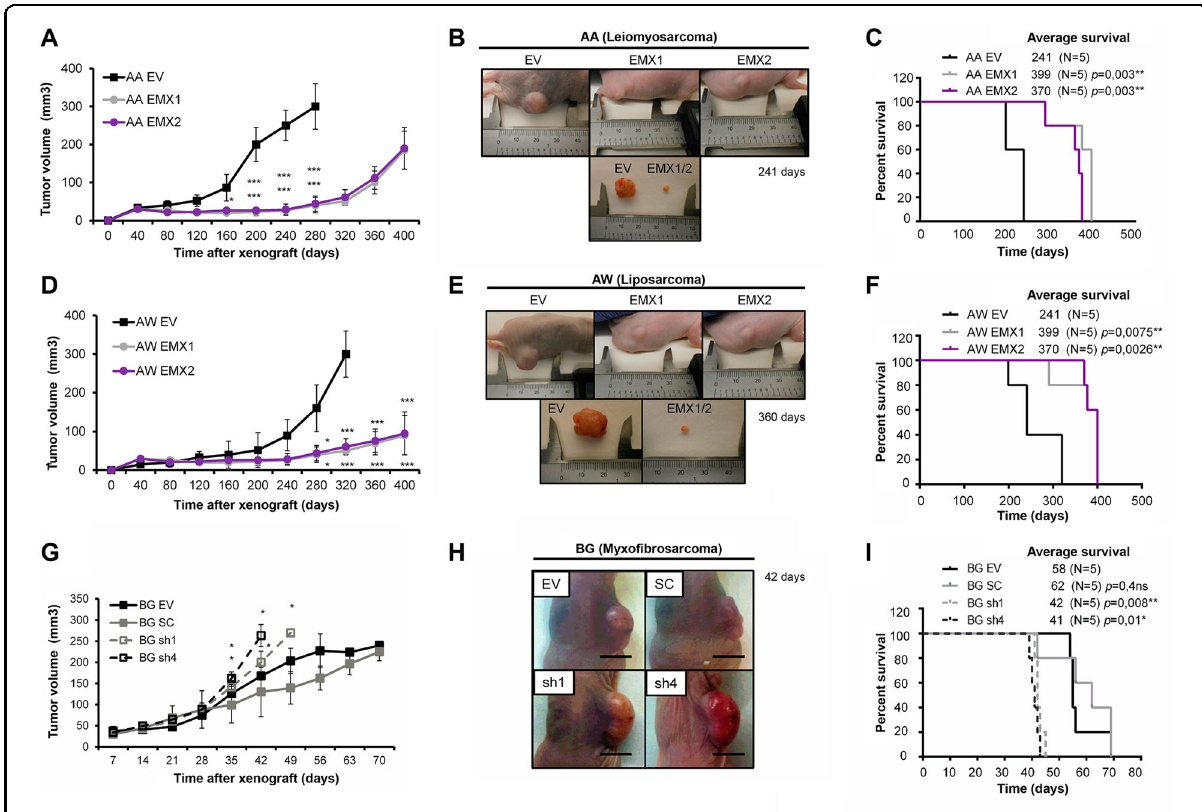
Fig. 2 Growth in vivo of sarcoma cell lines with different levels of EMX proteins. A – F Effect of EMX1 or EMX2 overexpression on the growth of xenotransplants of AA and AW models. A , D Graph of the growth of xenograft tumors in the immunosuppressed mice with the AA ( A ) and AW ( D ) cell lines. B , E Images of the tumors in a mouse and a detailed image of the tumor size of the parental line with respect to the representative size of the lines EMX1 and EMX2 of AA ( B ) and AW ( E ). In C and F , the survival of the different cohorts of immunosuppressed mice injected with AA ( C ) and AW ( F ) is indicated. G – I Effect of reduction of EMX1 and EMX2 on tumor growth of the xenografts of the BG sarcoma cell line with different levels of EMX. G Tumor growth of xenograft tumors in the immunosuppressed mice from BG-derived cell lines. H Representative photographs of the tumors already grown in the mouse on day 42. The bar corresponds to 0.5 cm. I Survival of the different cohorts of immunosuppressed mice. The p -value of the survival graphs was obtained using the LogRank test. The rest of the analysis was performed with Student ’ s t -test (* p < 0.05; ** p < 0.01; *** p <